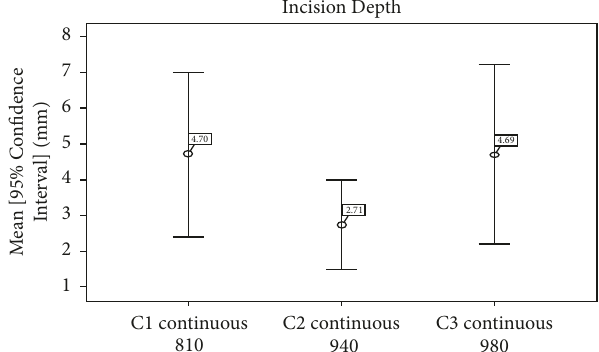
Figure 5: Average incision depths of groups C1, C2, and C3.